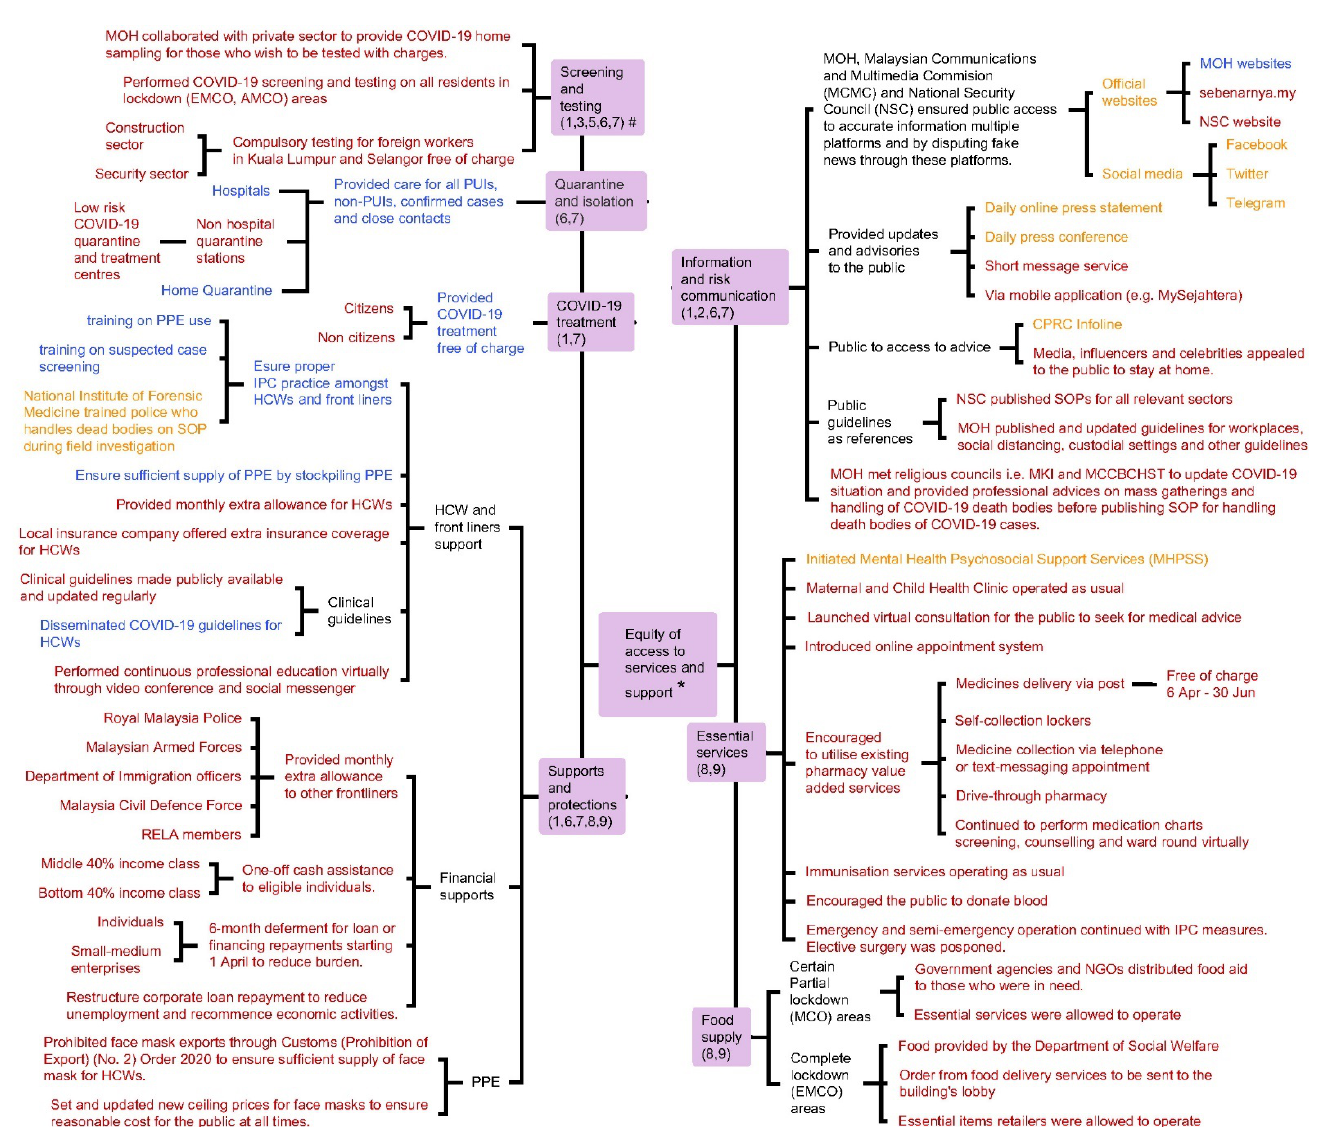
Figure A4. Equity of access to services and support provided by Malaysian government during the COVID-19 pandemic. # Numbers in parentheses denote WHO Pillars. * Measures implemented: (i) before the first wave (31 December to 24 January) indicated in blue, (ii) during the first wave (25 January–26 February) indicated in orange, and (iii) during the second wave (27 February onwards) indicated in red.